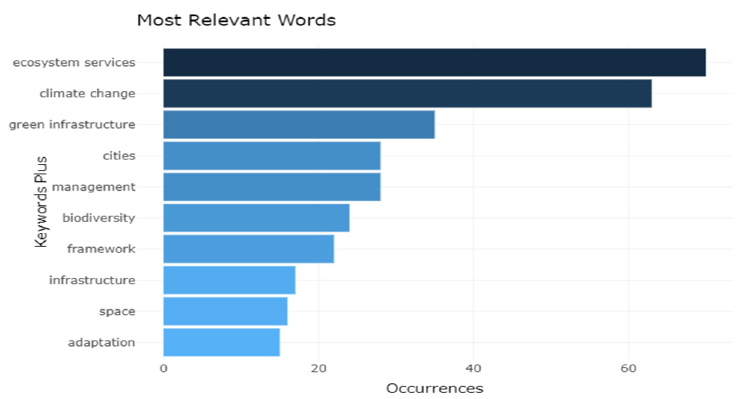
Figure 6. Comparison of Keywords Plus by number of occurrences. Source: Biblioshiny. Own compilation.